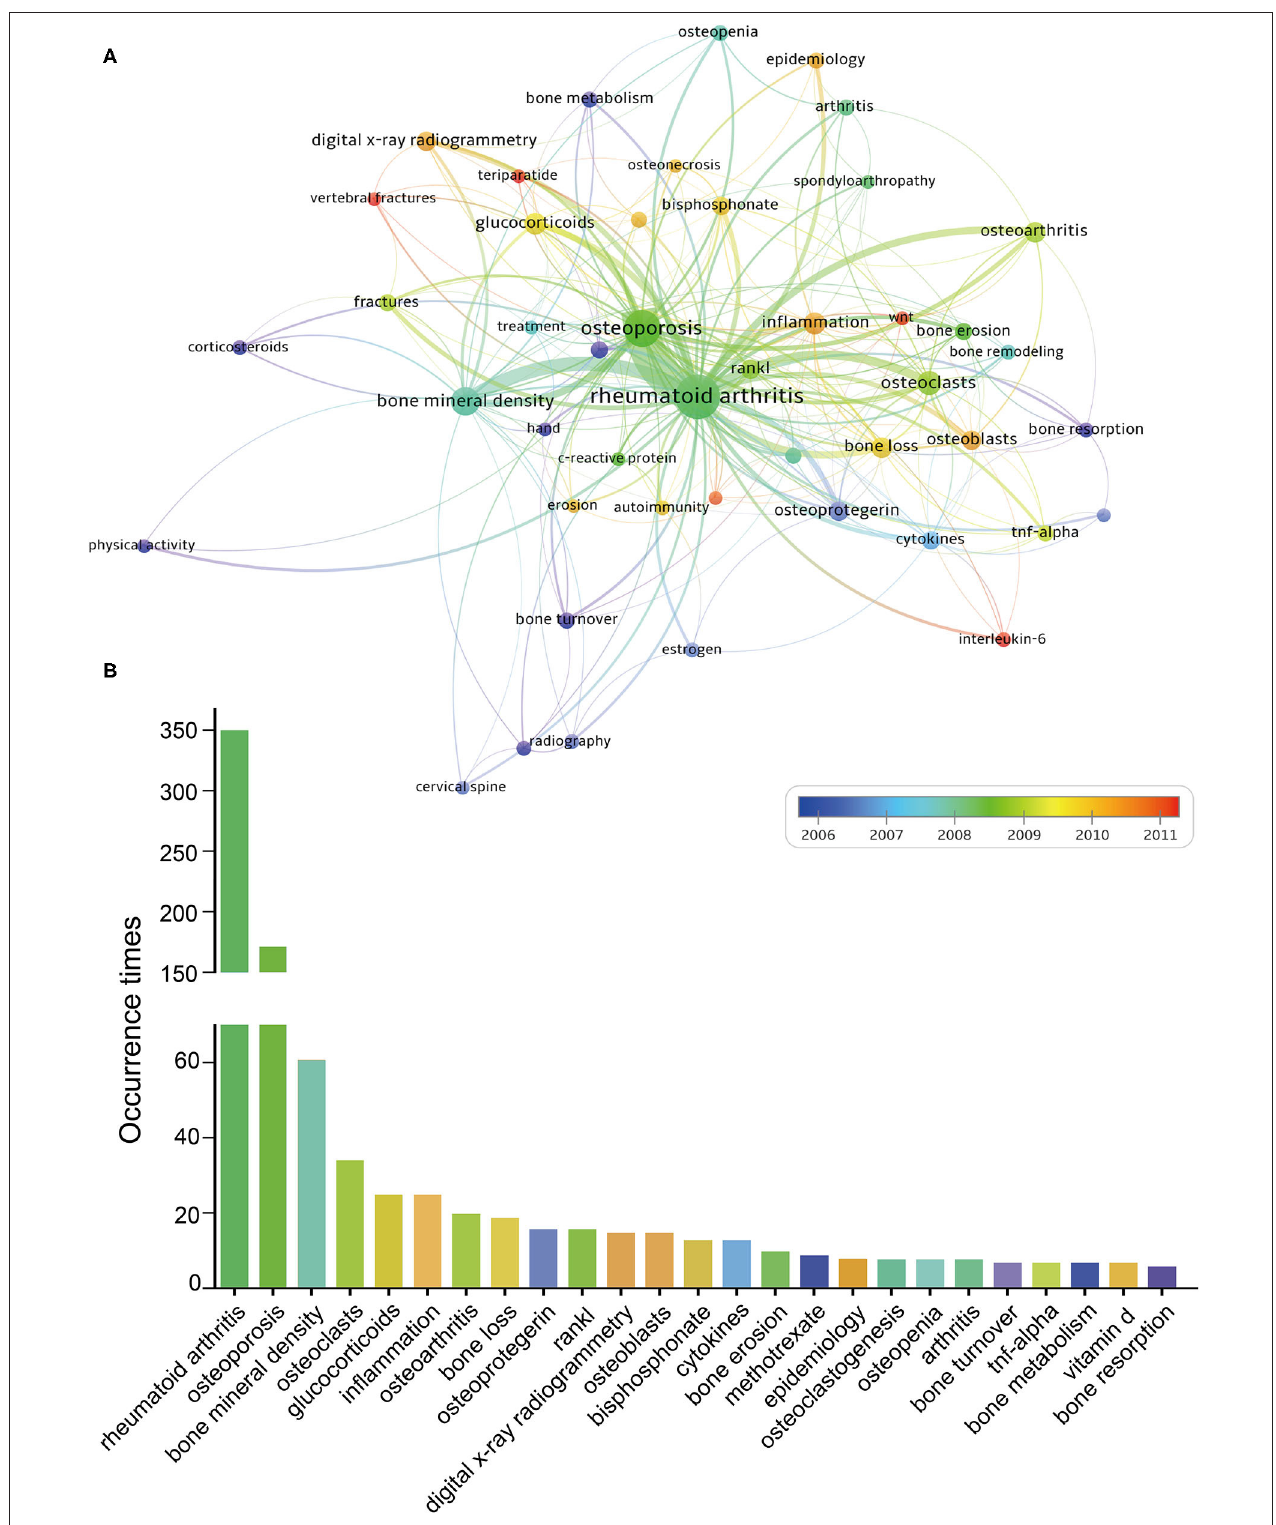
FIGURE 7 | (A) Overlay visualization map of keywords co-occurrence analysis. (B) The top 25 keywords with the largest occurrence times.